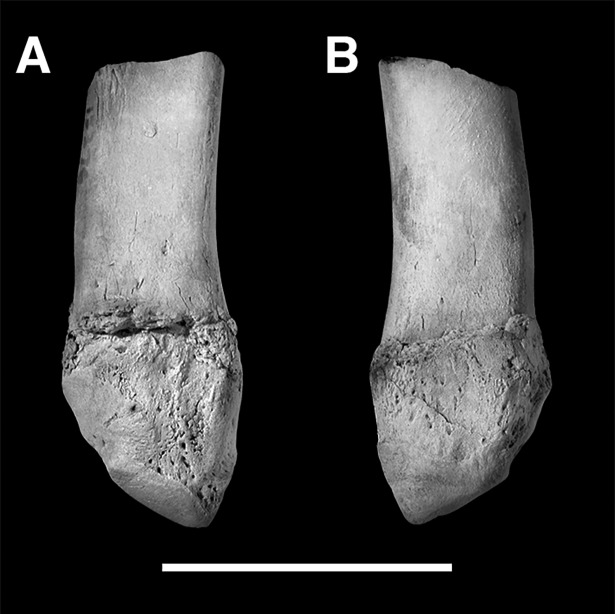
Left distal ulna of Periptychus carinidens (USNM 15376).(A) anterior view; (B) posterior view. (specimen has been coated in ammonium chloride prior to photographing). Scale bar: 30mm.